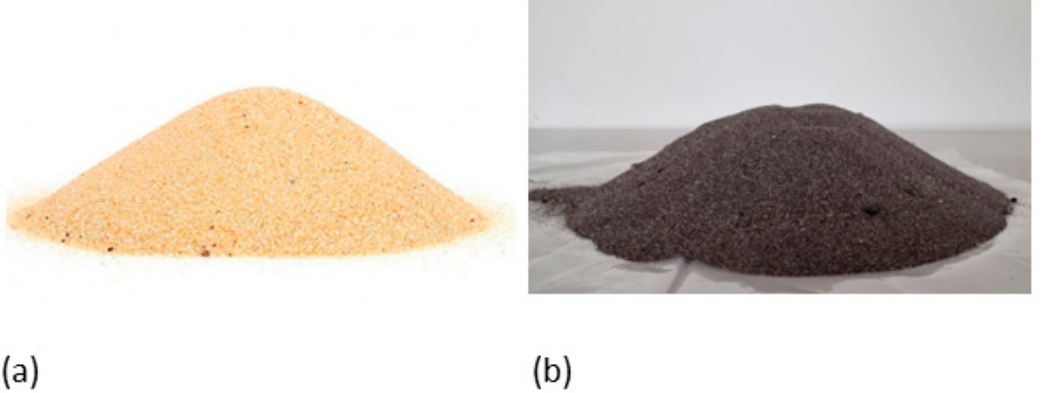
Figure 2. Samples of Virgin sand ( a ); and WFS ( b ).